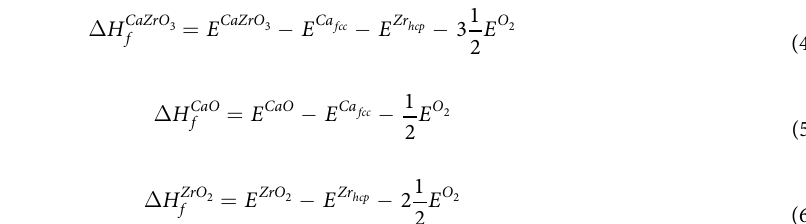
Here ∆ H fCaZrO 3 , ∆ H fCaO and ∆ H fZrO 2 are the enthalpies of formation of CZO, CaO and ZrO 2 , respectively, which are computed using